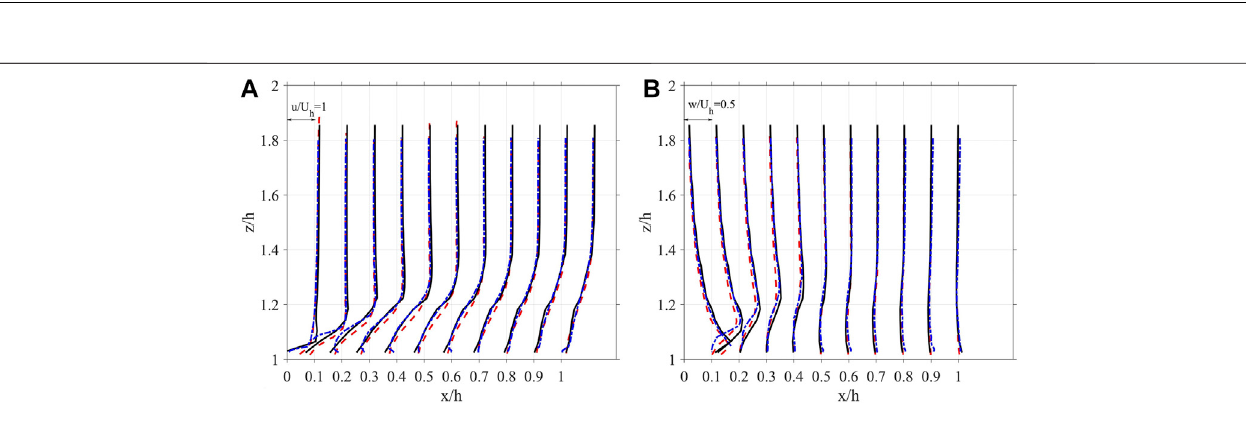
Frontiers in Mechanical Engineering |